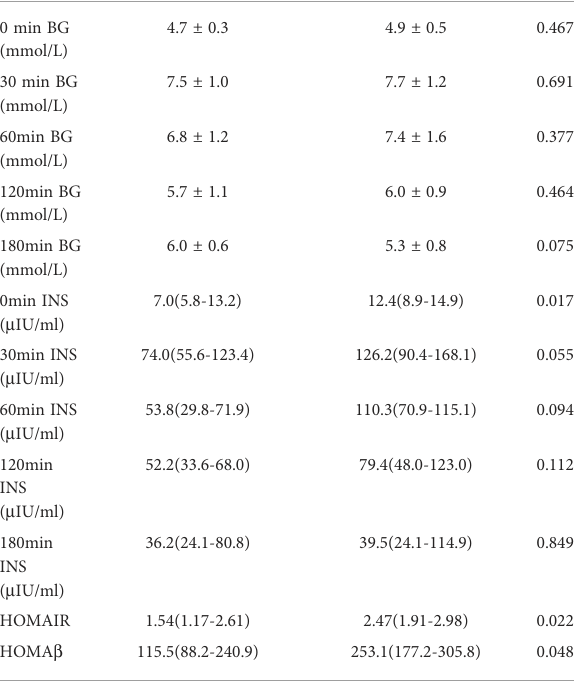
TABLE 2 Baseline OGTT results for 19 NGT patients categorized by kalemia situation. Hypokalemia (n=11) Normal kalemia